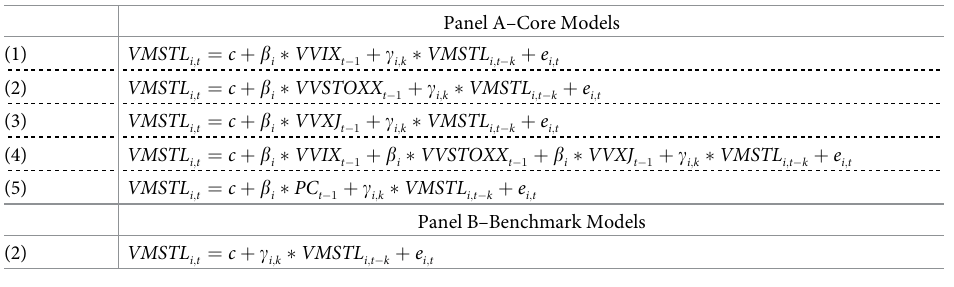
Table 3. Forecasting